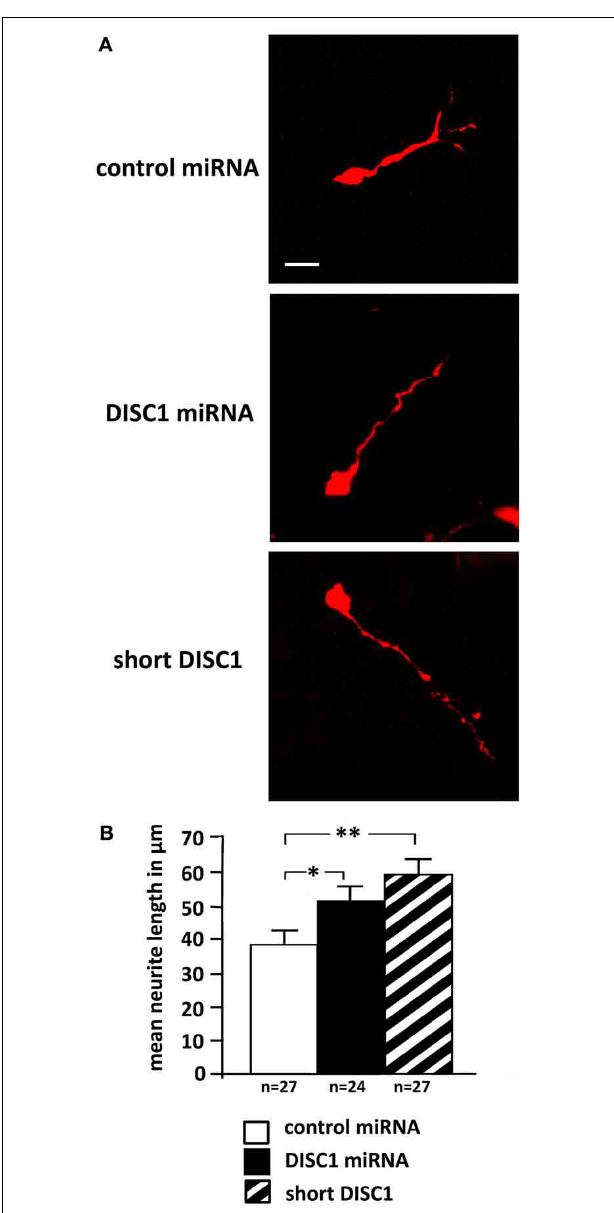
FIGURE 2 | Knockdown of DISC1 leads to prolonged leading processes in vivo . (A) Photomicrographs of cells after in utero electroporation show alterations in process morpholgy. (B) Quantification of the neurite length revealed prolonged leading processes after expression of DISC1 miRNA and short DISC1. Student’s t- test: ∗ p < 0 . 05, ∗∗ p < 0 . 005. Error bars: s.e.m. “n” reflects number of